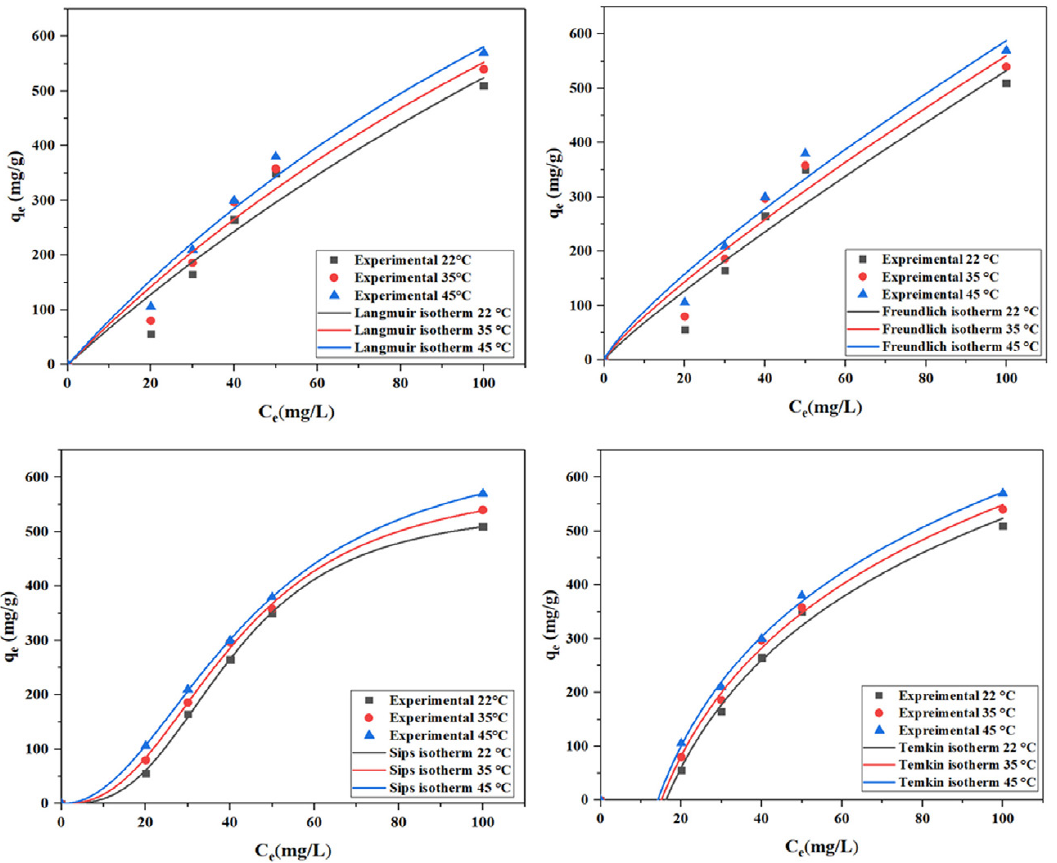
Fig. 12. Langmuir, Freundlich, Sips, and Temkin isotherm models for Cd(II) adsorption onto modified pectin/ γ -Fe